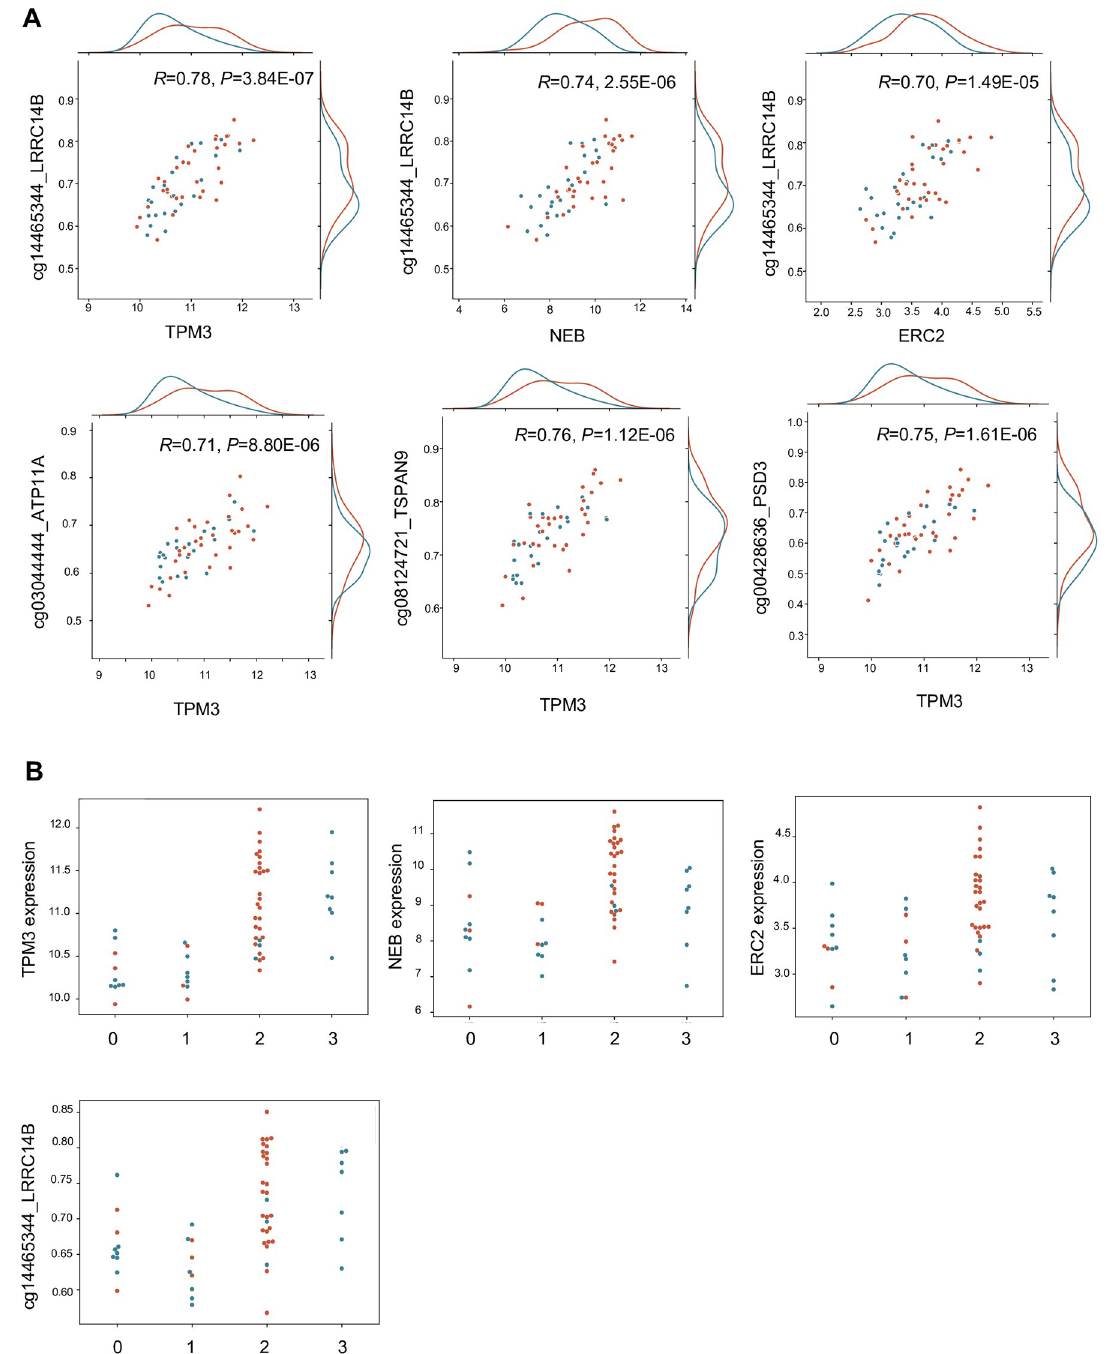
Fig 8. Scatterplots showing the association between key gene and CpG features. A) Scatterplots showing the correlation of ERC2 , NEB and TPM3 with the CpG site on LRRC14B . Additionally, it represents some of the highly correlating gene and CpG pairs involving high node-degree and differentially expressed genes. B) The expression of the genes and the CpG methylation is visualized by partitioning the samples into clusters as determined using the latent factor profile. The expression of the NEB , TPM3 is particularly high in the cluster 2, which also has a high number of DCM samples.